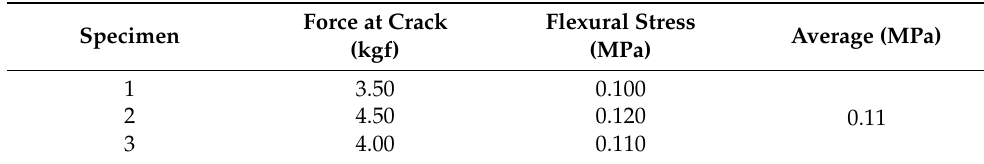
Table 3. Results of flexural test on